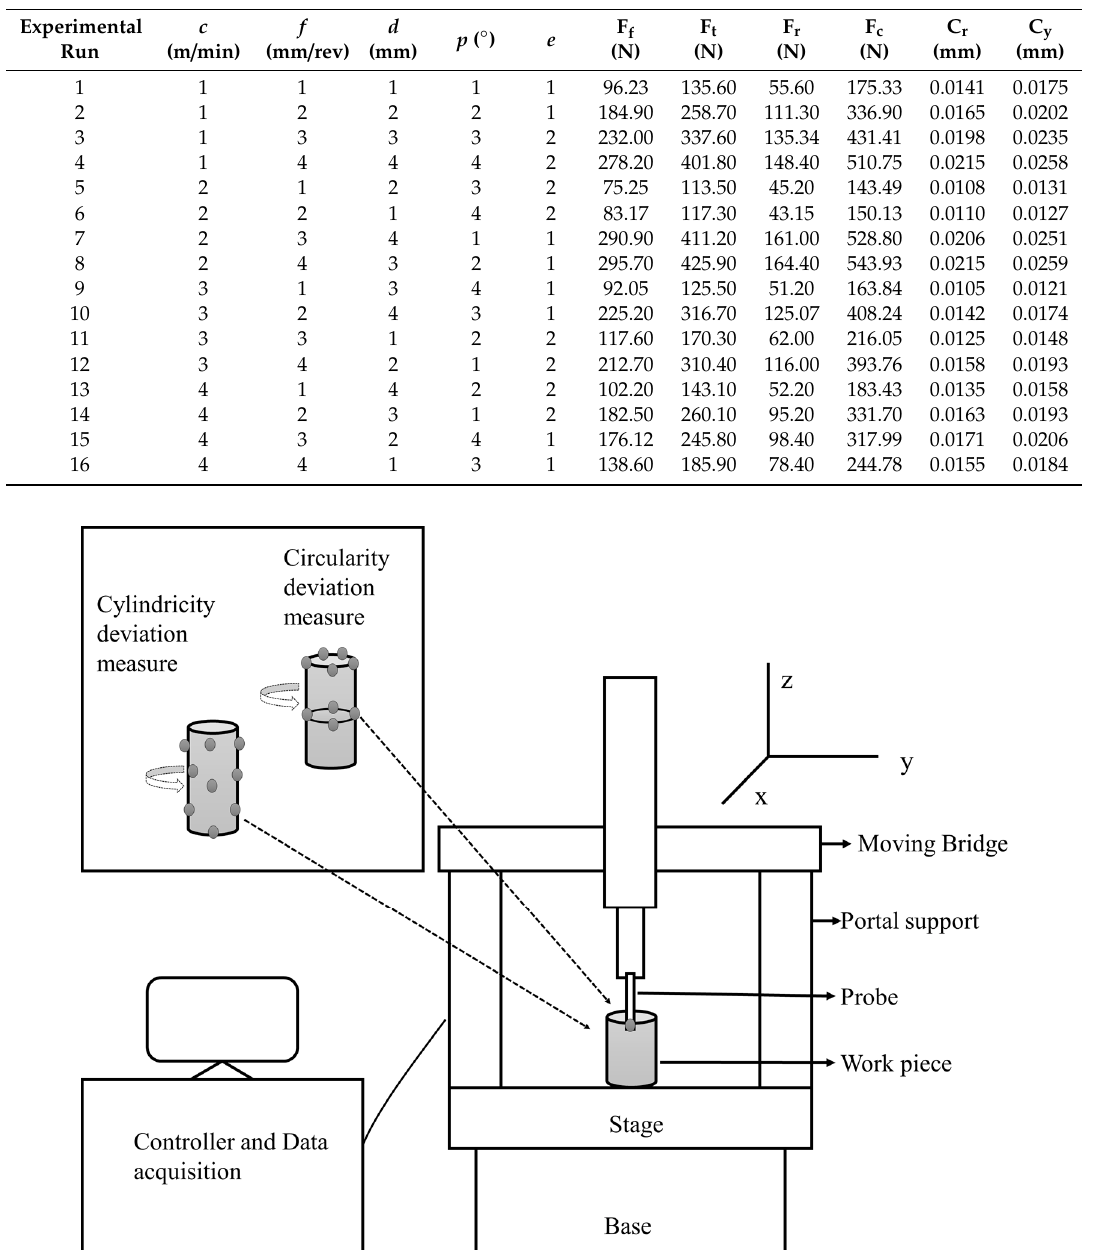
Table 2. Experimental runs based on Taguchi orthogonal array design L 16 and measured responses. Experimental Run